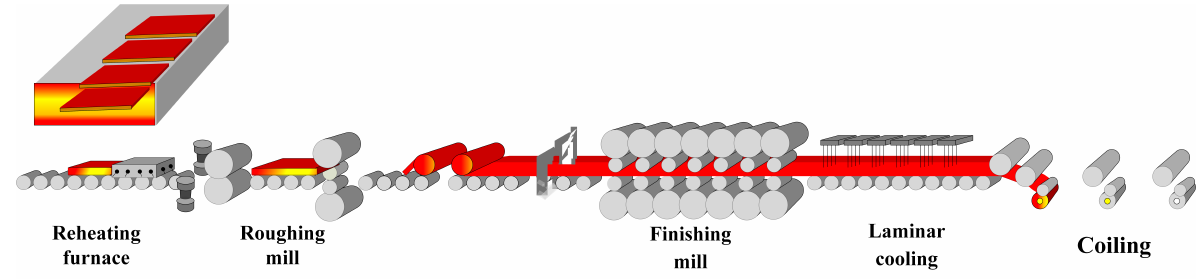
Figure 1. The flowchart schematic diagram of hot steel strip rolling.